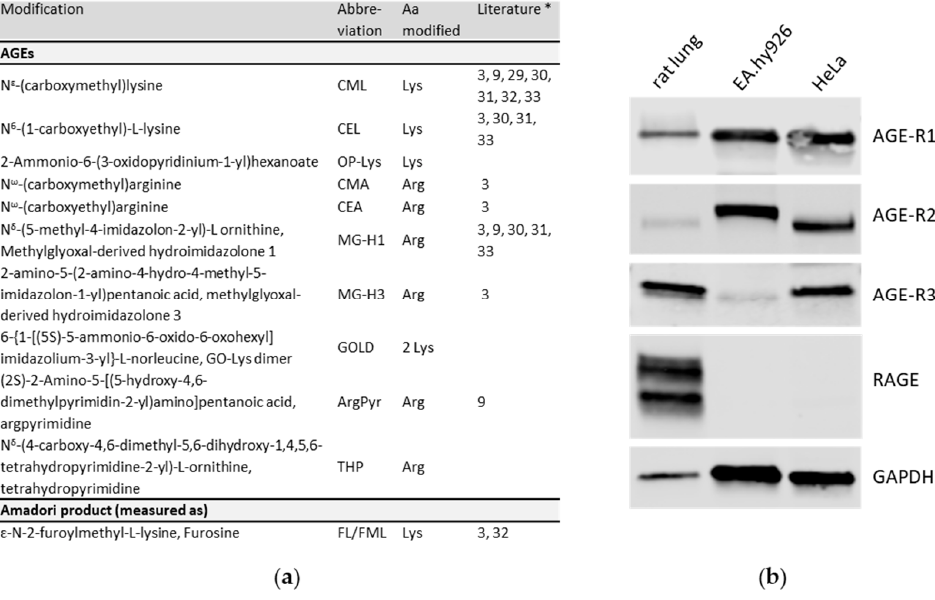
Figure 9. Identification of AGE-modifications in BCE: ( a ) Putatively active protein-modifications in BCE hydrolysate identified by HPLC-MS/MS (Literature*: AGEs and Amadori products already described in bread). ( b ) Expression of different receptors for AGEs was determined by Western blotting with indicated antibodies in EA.hy926 and HeLa cells. Lung lysate from rats was used as a positive control for RAGE expression and GAPDH served as a loading control.